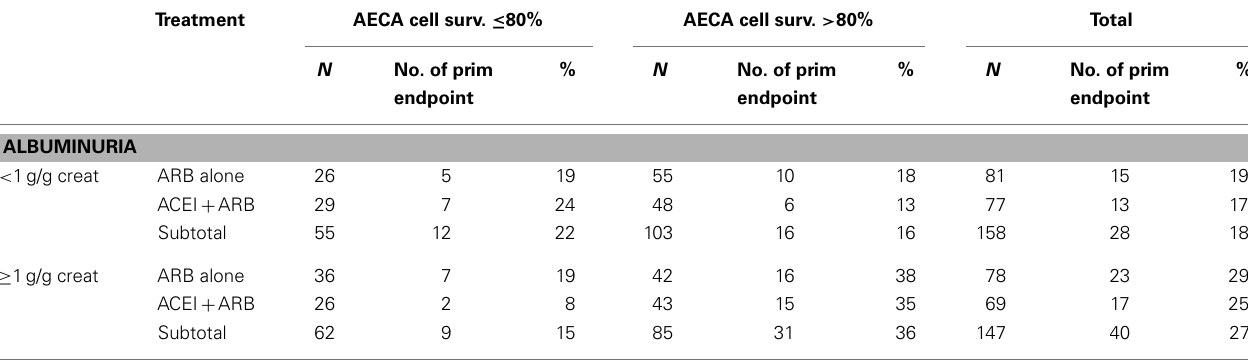
Table 3 |Association between anti-endothelial cell antibody-mediated cell survival group and primary endpoint by treatment and baseline albuminuria group